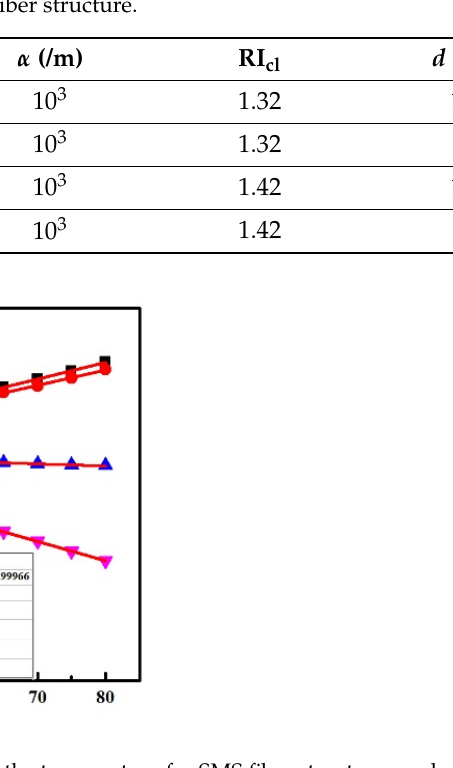
Figure 7. Dip Wavelength as a function of the temperature for SMS fiber structures, only the TOE co is taken into account in the simulation.